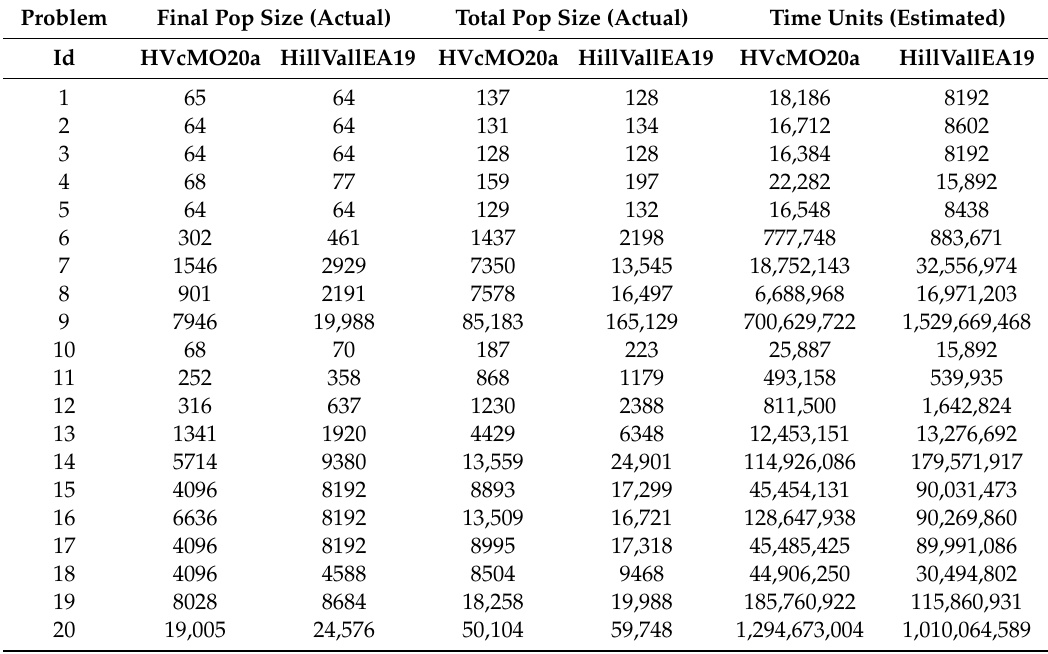
Table A4. Mean population size and running time over 50 runs with tolerance of 1.0 × 10 − 5 .